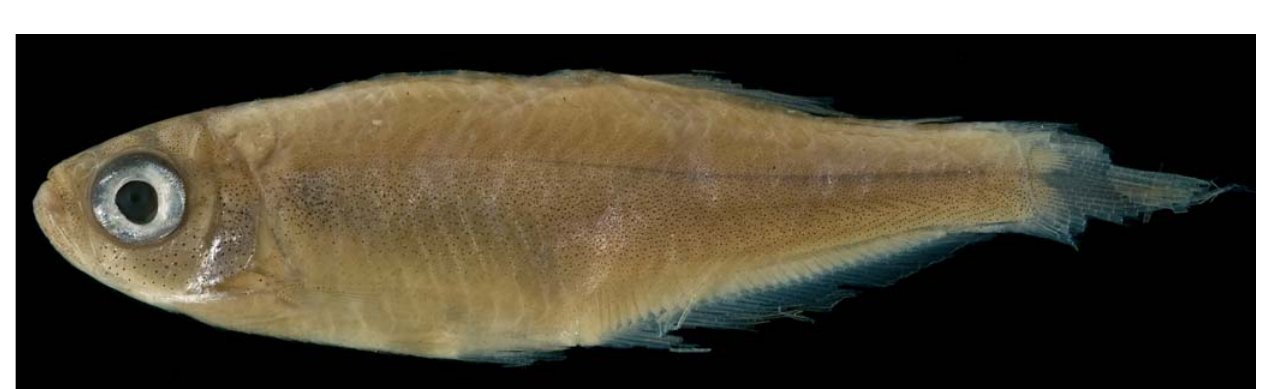
Fig. 45. Mimagoniates pulcher , male, MNRJ 17814, SL 35.0 mm SL, Brazil, Mato Grosso, “Porto Velho-São Luís de Cáceres”, holotype.